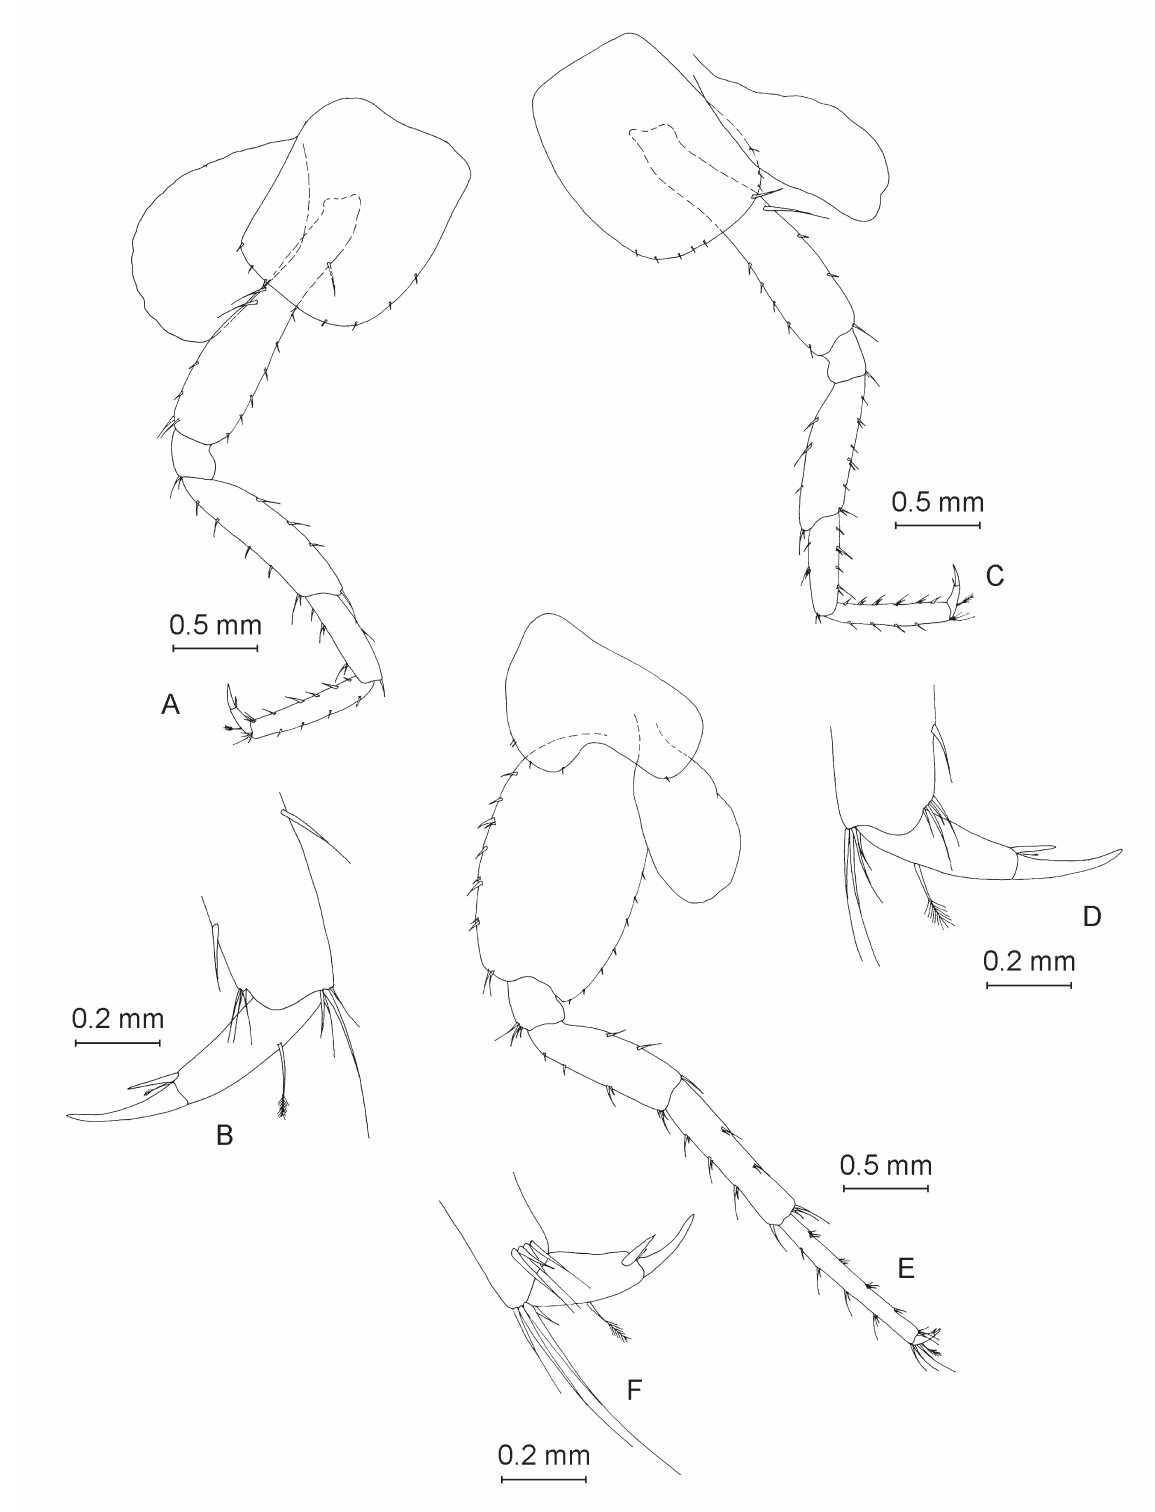
Fig. 12. ♀. A . Pereopod III. B . Dactylus of pereopod III. C . Pereopod IV. D . Dactylus of pereopod IV. E . Pereopod V. F . Dactylus of pereopod